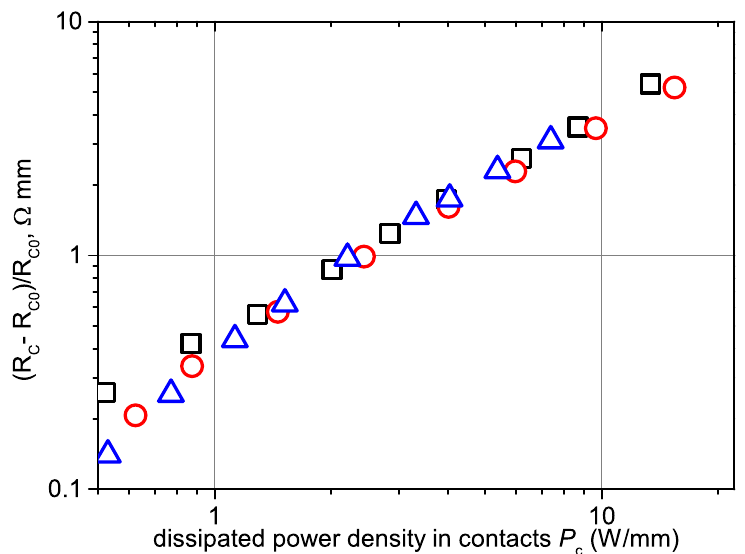
Figure 7. The dependence of the relative contact resistance change ( R c − R c0 ) / R c0 on the dissipated electric power density P c in contacts for different samples; AlGaN/GaN (squares), AlGaN/AlN/GaN (triangles and